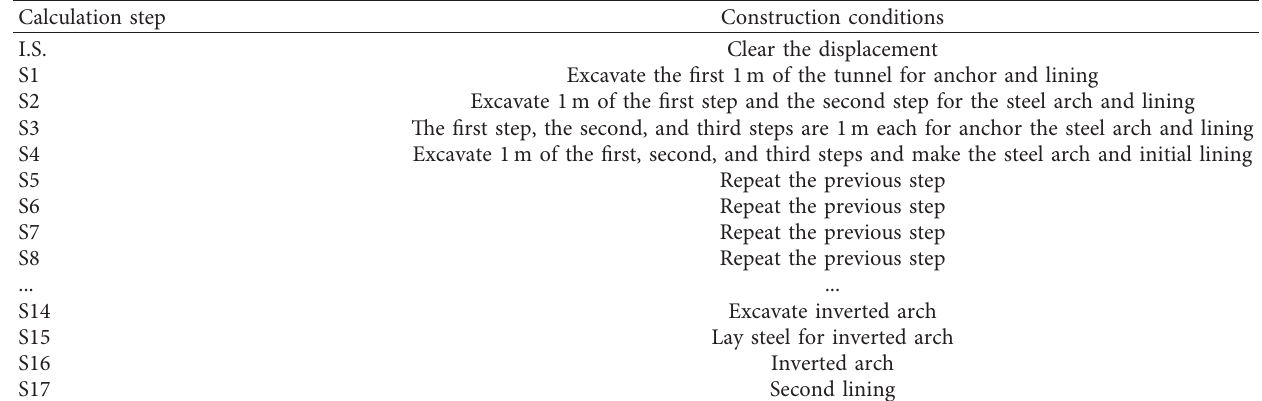
Table 5: Main calculation steps of the three-step method.